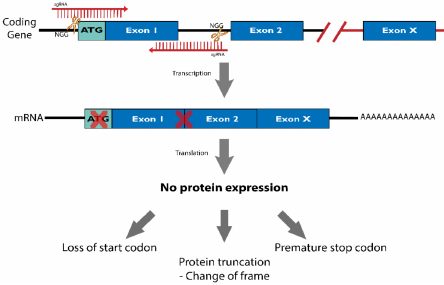
Figure 6. Editing protein-coding genes with CRISPR/Cas9. Targeting protein coding genes with CRISPR/Cas9-mediate gene editing. The objective is to disrupt the coding sequence using sgRNAs targeting the first exons of the gene, close to the start codon “ATG”. As a result, loss of protein expression is expected due to deletions or insertions that may disrupt the start codon, change protein frame or even insert a premature stop codon.